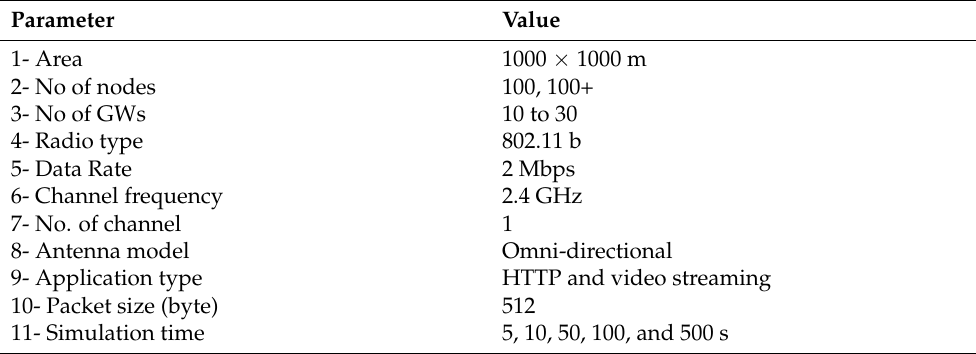
Table 2. MATLAB 9.1 simulation parameters.